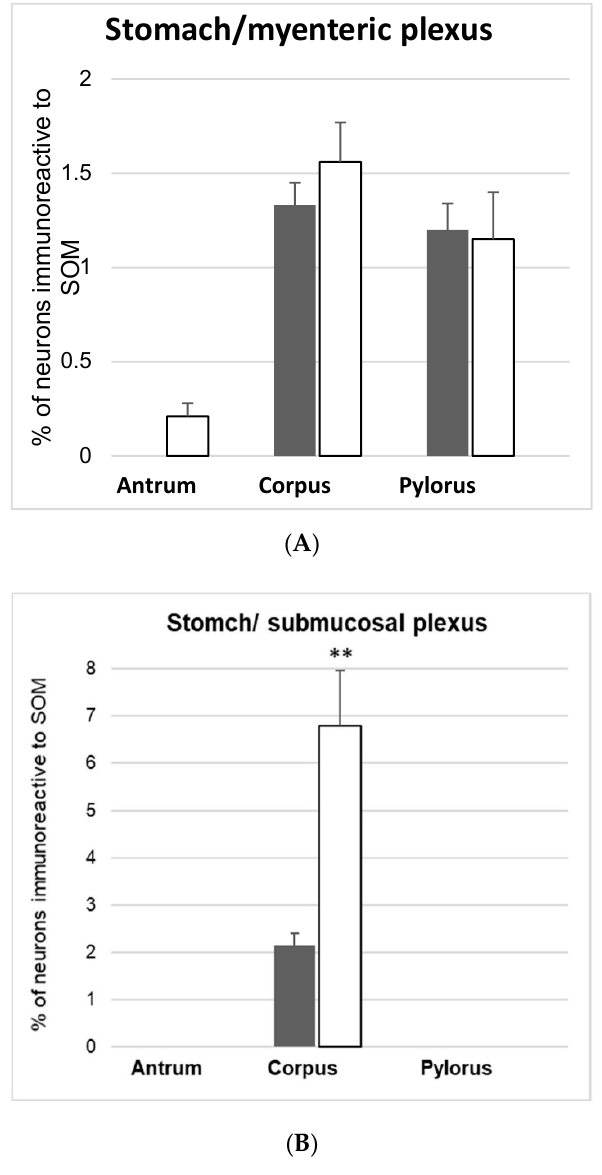
Figure 2. Mean (±SEM) of SOM, like immunoreactive (SOM-IL), neurons in the myenteric plexus ( A ) and submucosal plexus ( B ) of stomach in the control (white bars) and streptozotocine-induced diabetes groups (grey bars). Data are presented as mean ± SEM and statistically significant data (* p < 0.05, ** p < 0.01, and *** p < 0.001).